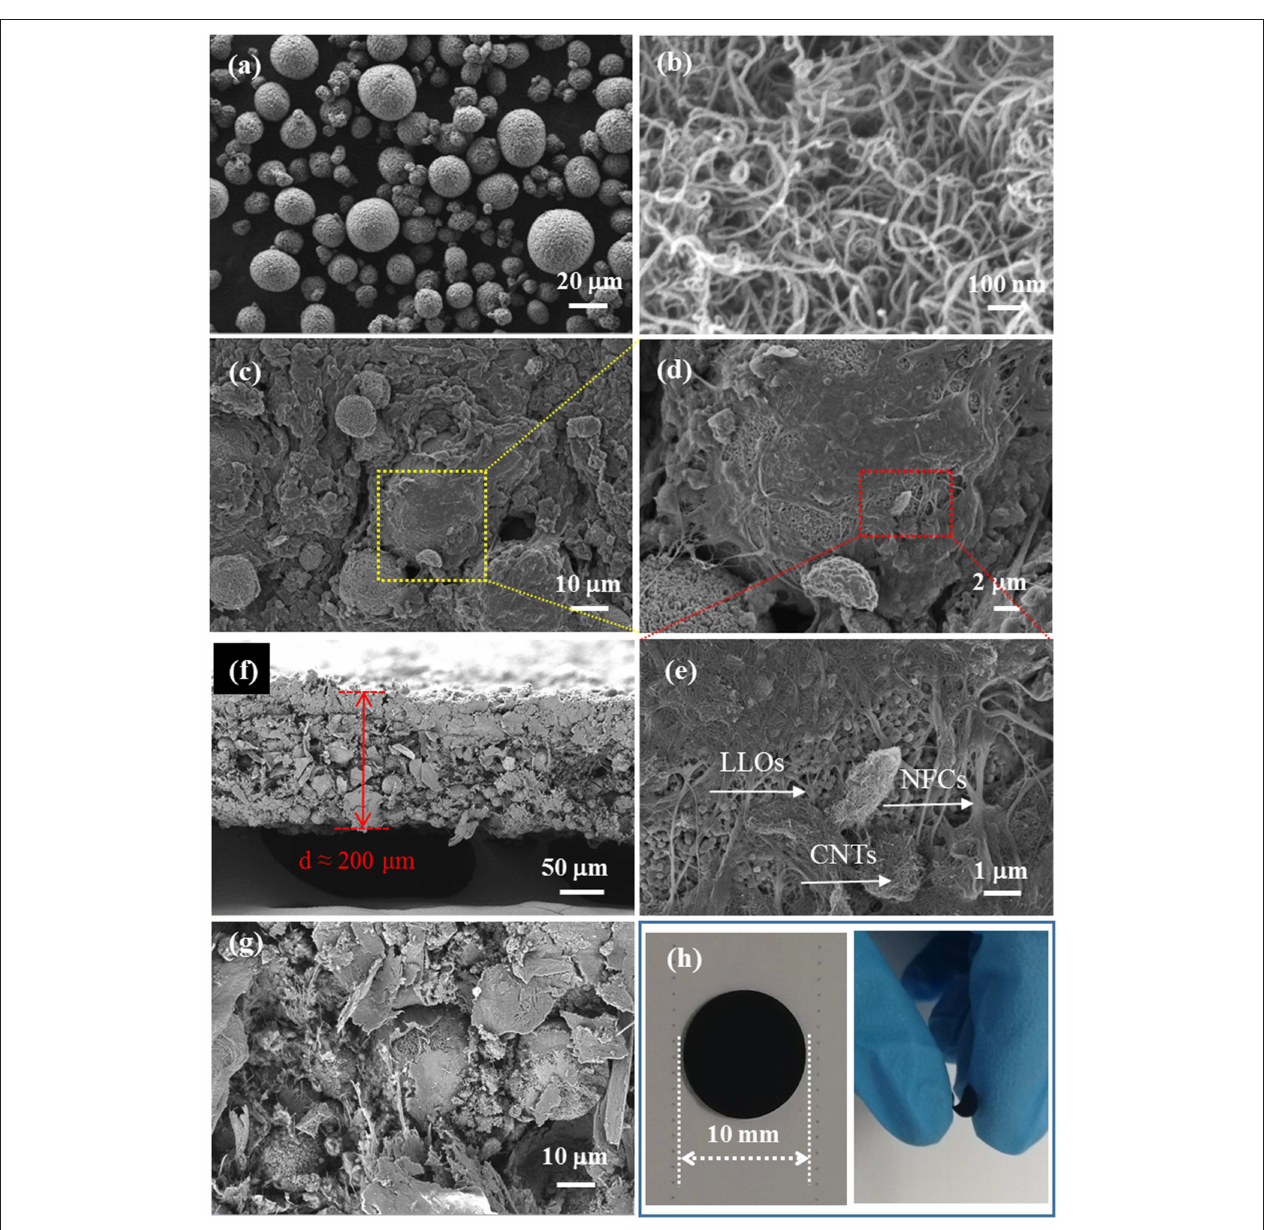
FIGURE 3 | SEM images of (a) LLOs, (b) CNTs, (c–e) LLOs/CNTs/NFCs electrode; (f,g) Cross-section images of the LLOs/CNTs/NFCs electrode; (h) the photos of LLOs/CNTs/NFCs electrode before and being